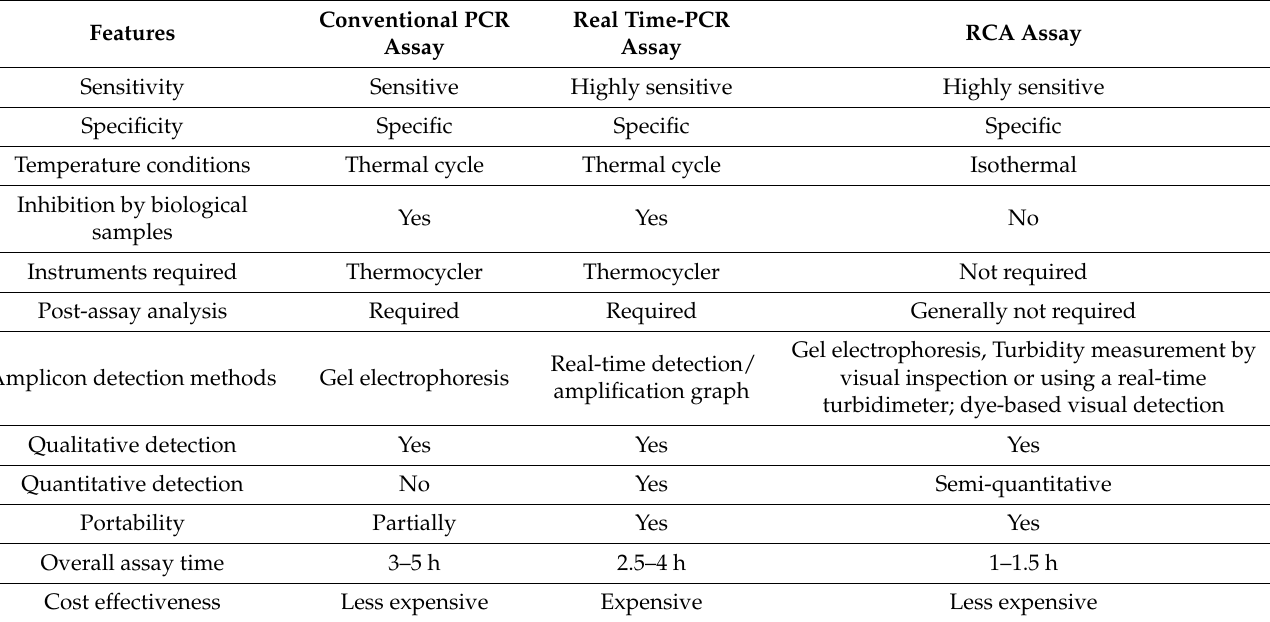
Table 1. Comparison of RCA, PCR and real-time PCR for the detection of